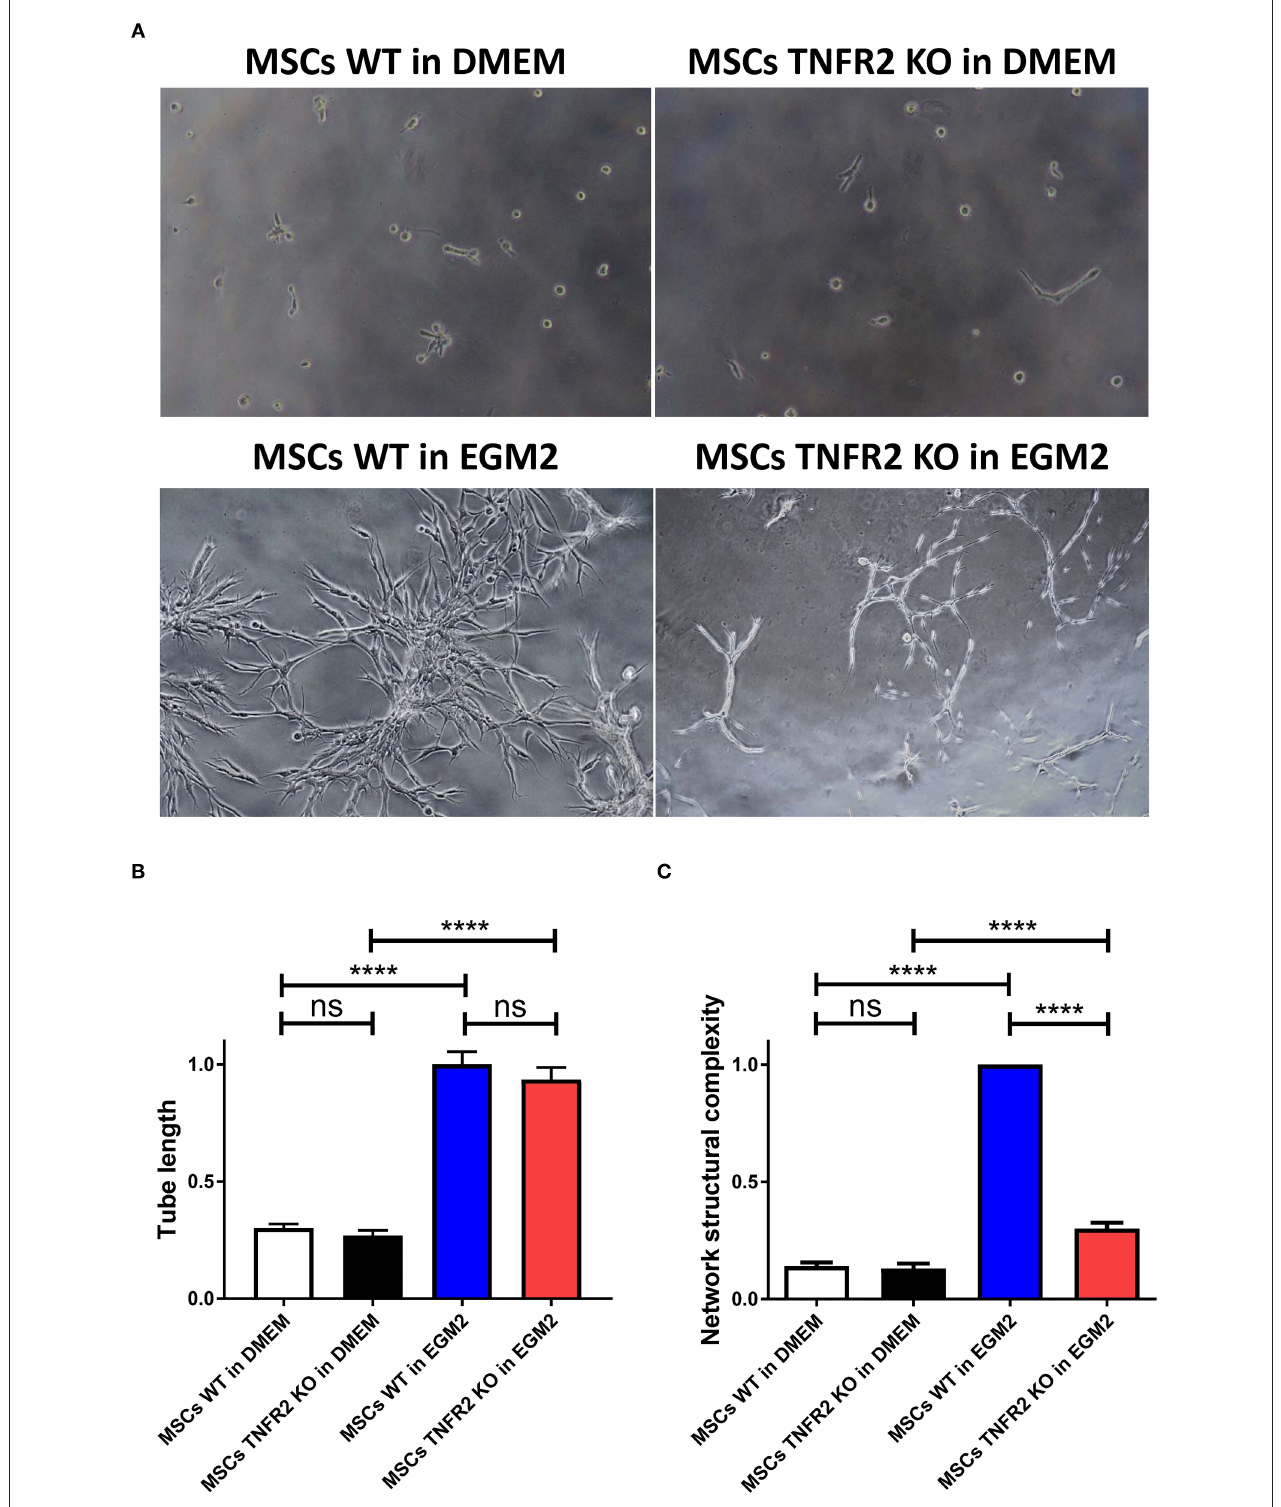
FIGURE 7 | The TNFR2 expression by mesenchymal stem cells (MSCs) is associated with their enhanced tube formation property. To evaluate the involvement of TNFR2 in MSC regenerative feature, wild-type (WT) and TNFR2 knockout (KO)-MSCs (P2 and P3) were cultured on Matrigel using either Dulbecco’s modified Eagle’s medium (DMEM) standard medium or EGM2 endothelial medium. (A) Pictures were taken every 2h, using objectives 4 × and 10 × of the inverted microscope in phase-contrast mode. (B) The tube length and (C) network structural complexity of WT and TNFR2 KO-MSCs were further evaluated. Results are collected from three independent experiments ( n =